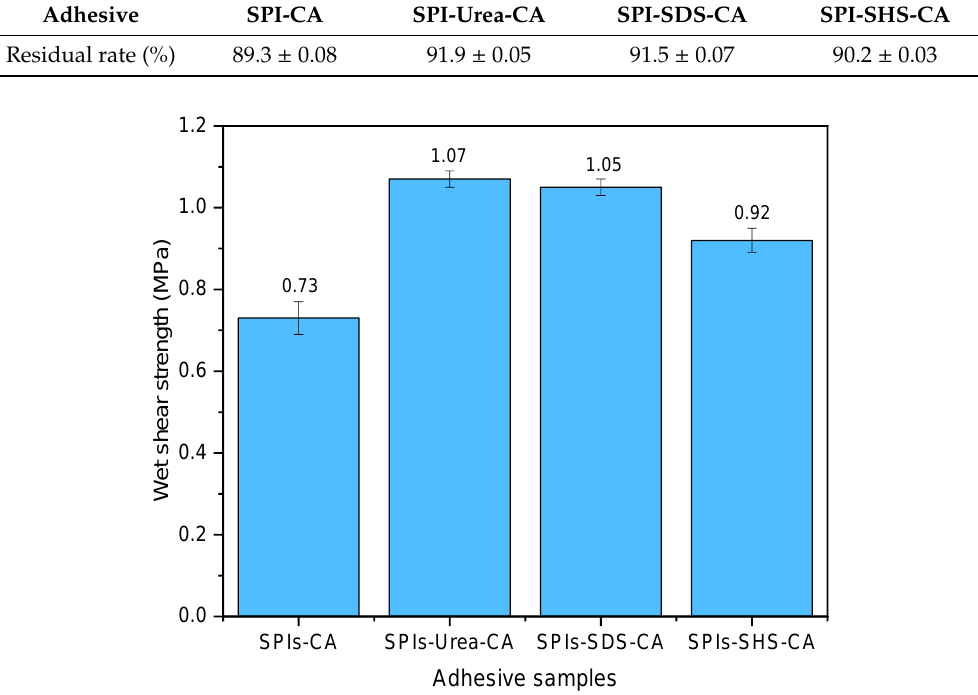
Figure 10. The wet shear strengths of plywood bonded by modified SPI adhesive of with CA.